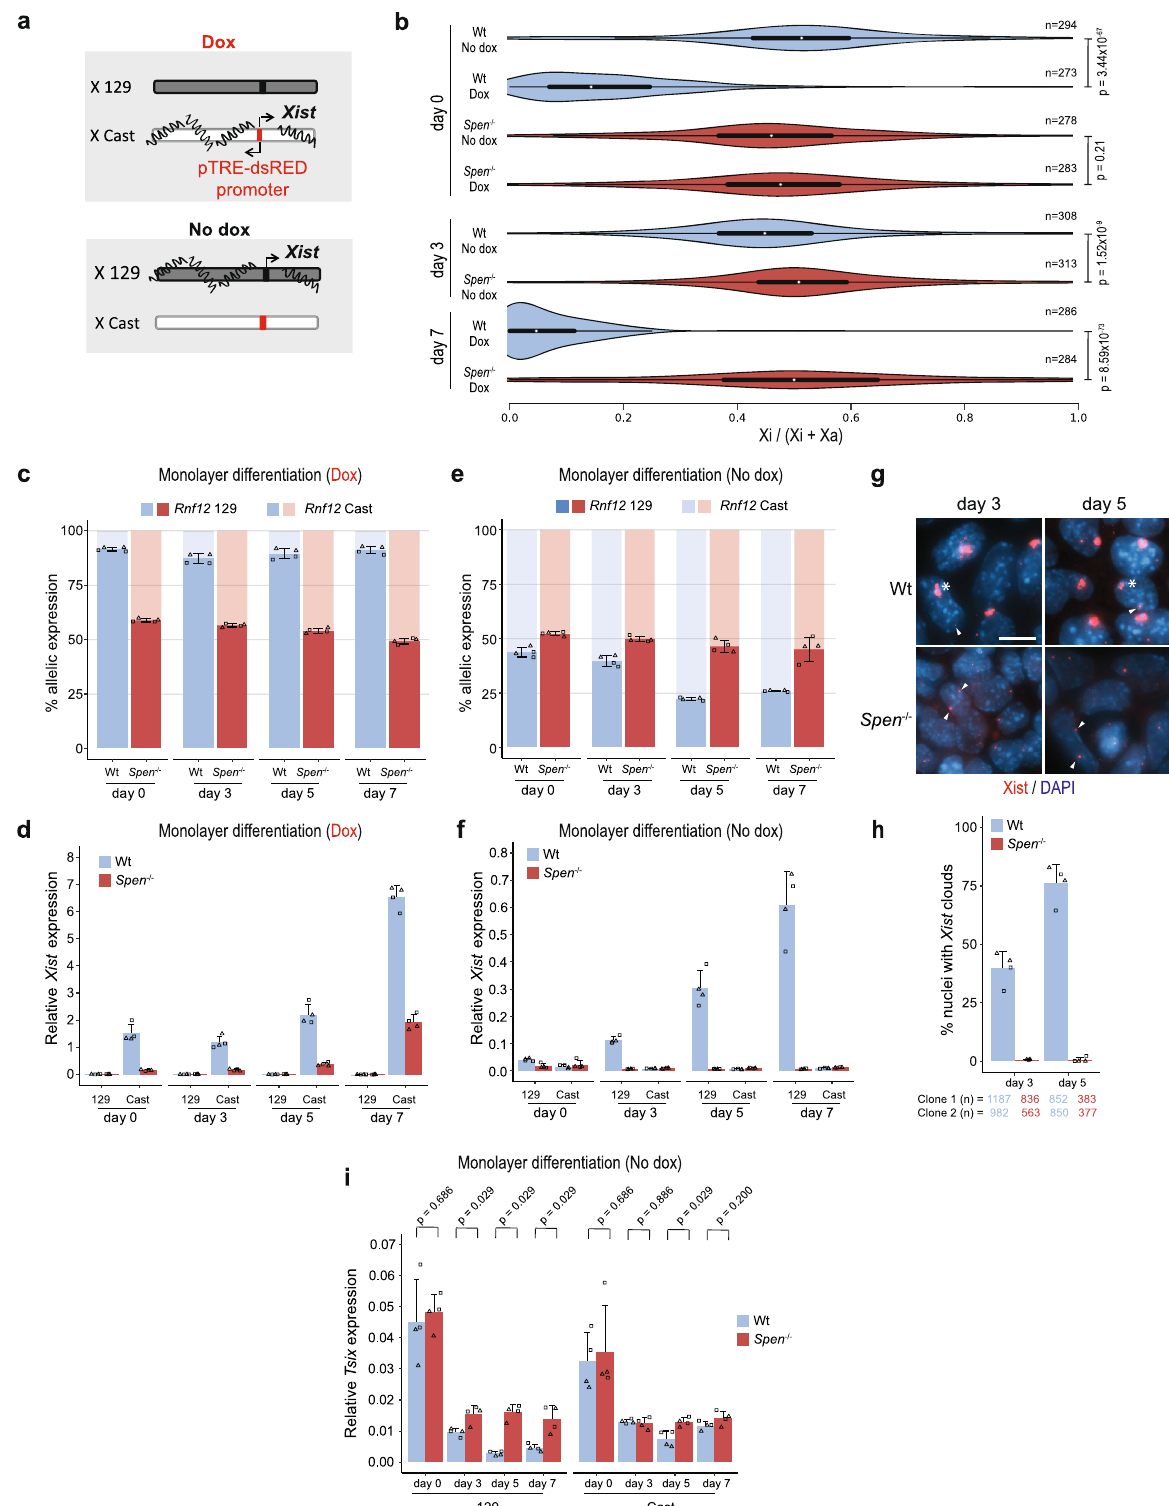
Successful integration was veri fi ed by gDNA PCR and con fi rmed by Spen mRNA and protein levels by RT-qPCR and Western blot, respectively (Supplementary Fig. 3b – d). The generated rescue clones (Clones A, B, and C) display two- to three-fold over- expression of Spen RNA at the ESC stage and during monolayer differentiation (Supplementary Fig. 3c). In contrast to the Spen − / − lines, all Spen − / − (cDNA) rescue clones express Xist at similar